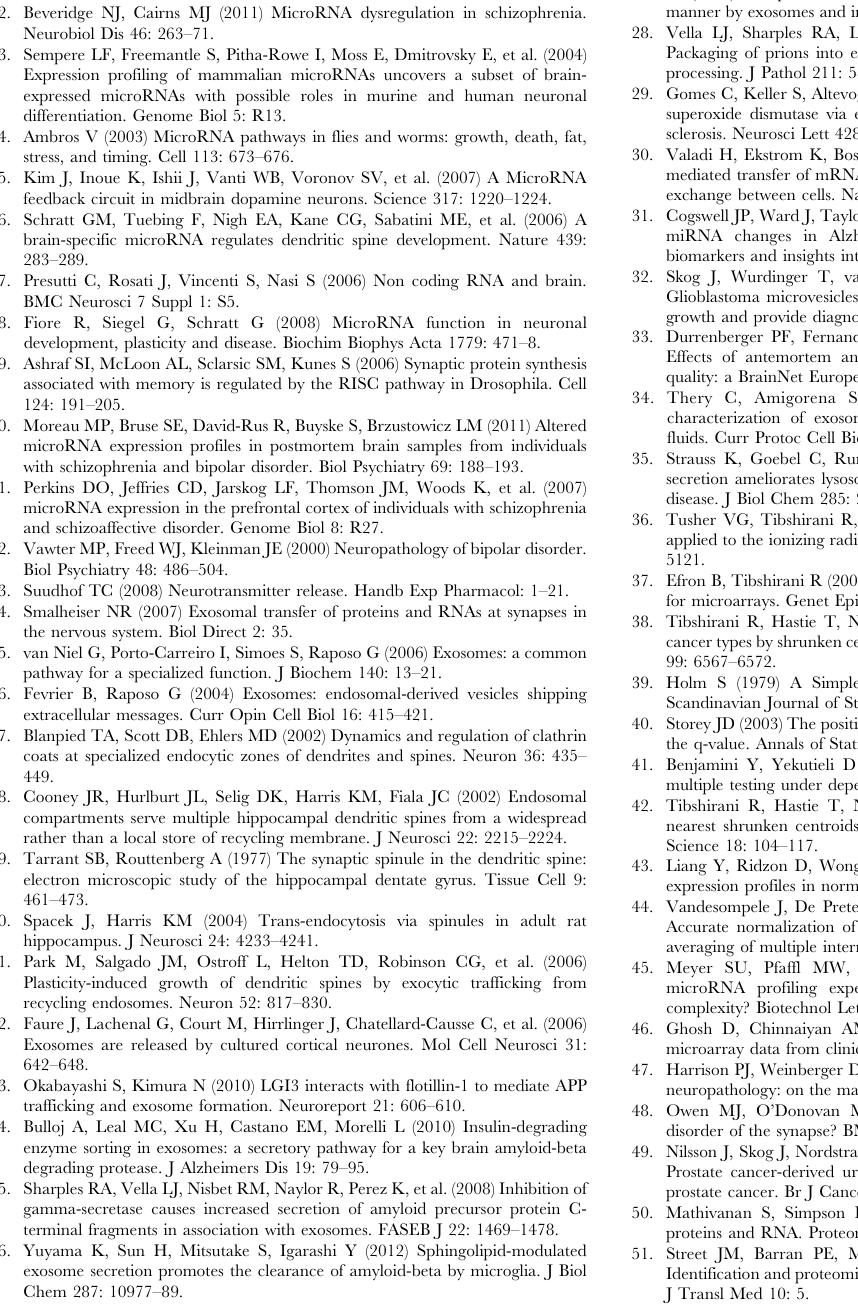
Table S5 An ANOVA analysis of differences in age between C, BD, and SZ groups of cases. No significant difference in age between the groups